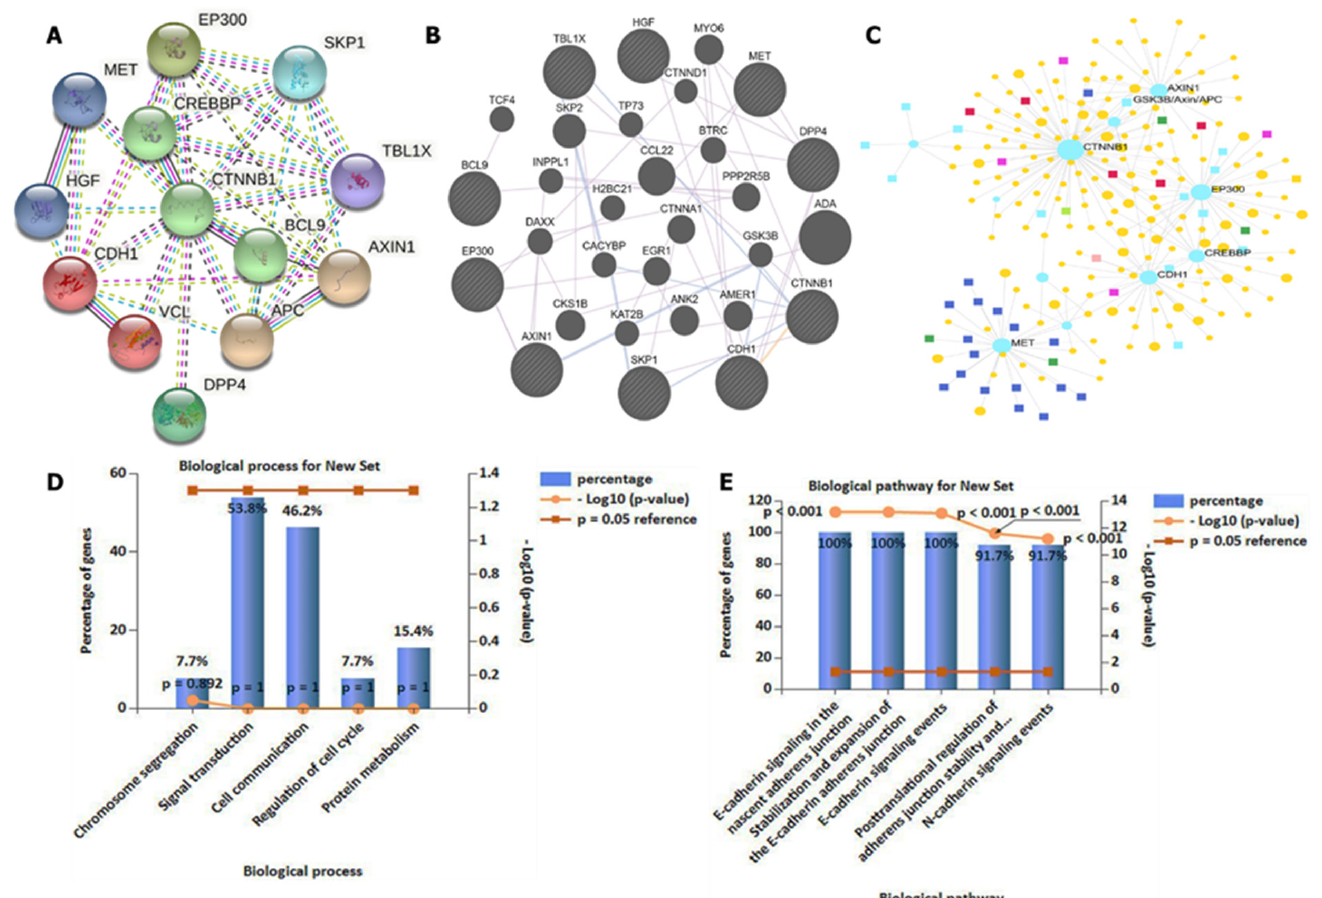
Figure 4. DPP4/CTNNB1/MET gene interactions co ‐ expressed in the same clustering network. ( A , B ) Interaction networks showing co ‐ expression between DPP4 and CTNNB1, MET and DPP4, CTNNB1 and MET, HFG and MET, DPP4 and CTNND1, and GSK3B and CTNND1 within the network clustering. An average local clustering coefficient of 0.787 was obtained, with an expected number of edges of 21 and an interaction p value of 0.006. ( C ) Gene enrichment analysis gene ontology (GO) showed enrichment in co ‐ expressions of CTNNB1, GSK3B, AXIN1 , and MET in biological processes. ( D , E ) Validation of GO, involving enrichment of the top five pathways involved, with p < 0.05 considered significant.